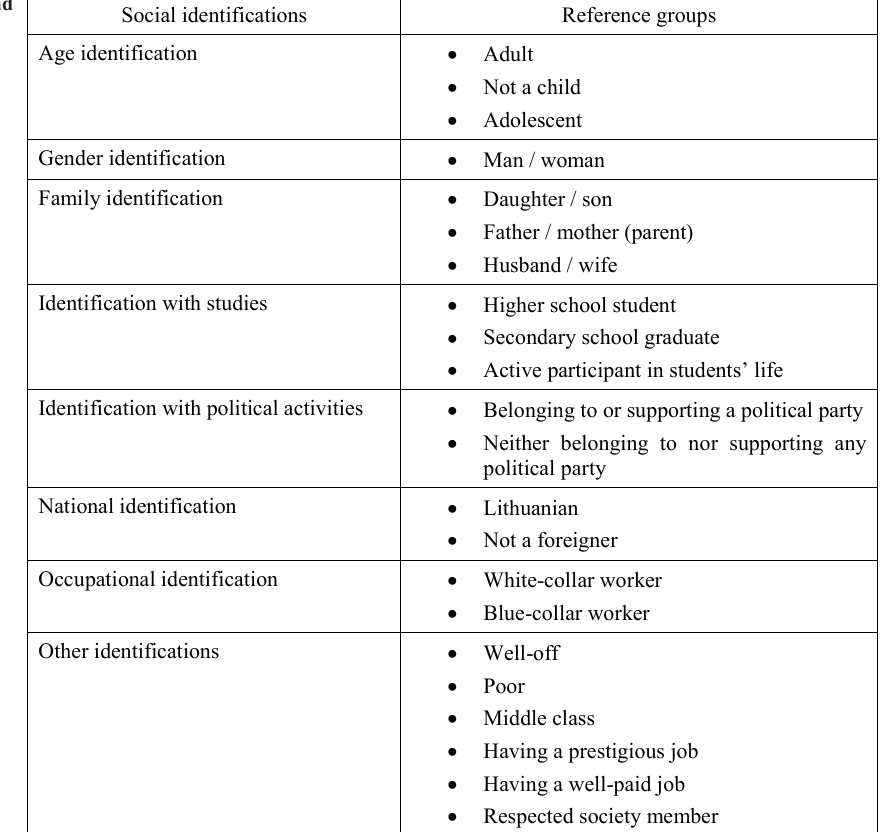
Table 1. Social identifications and reference